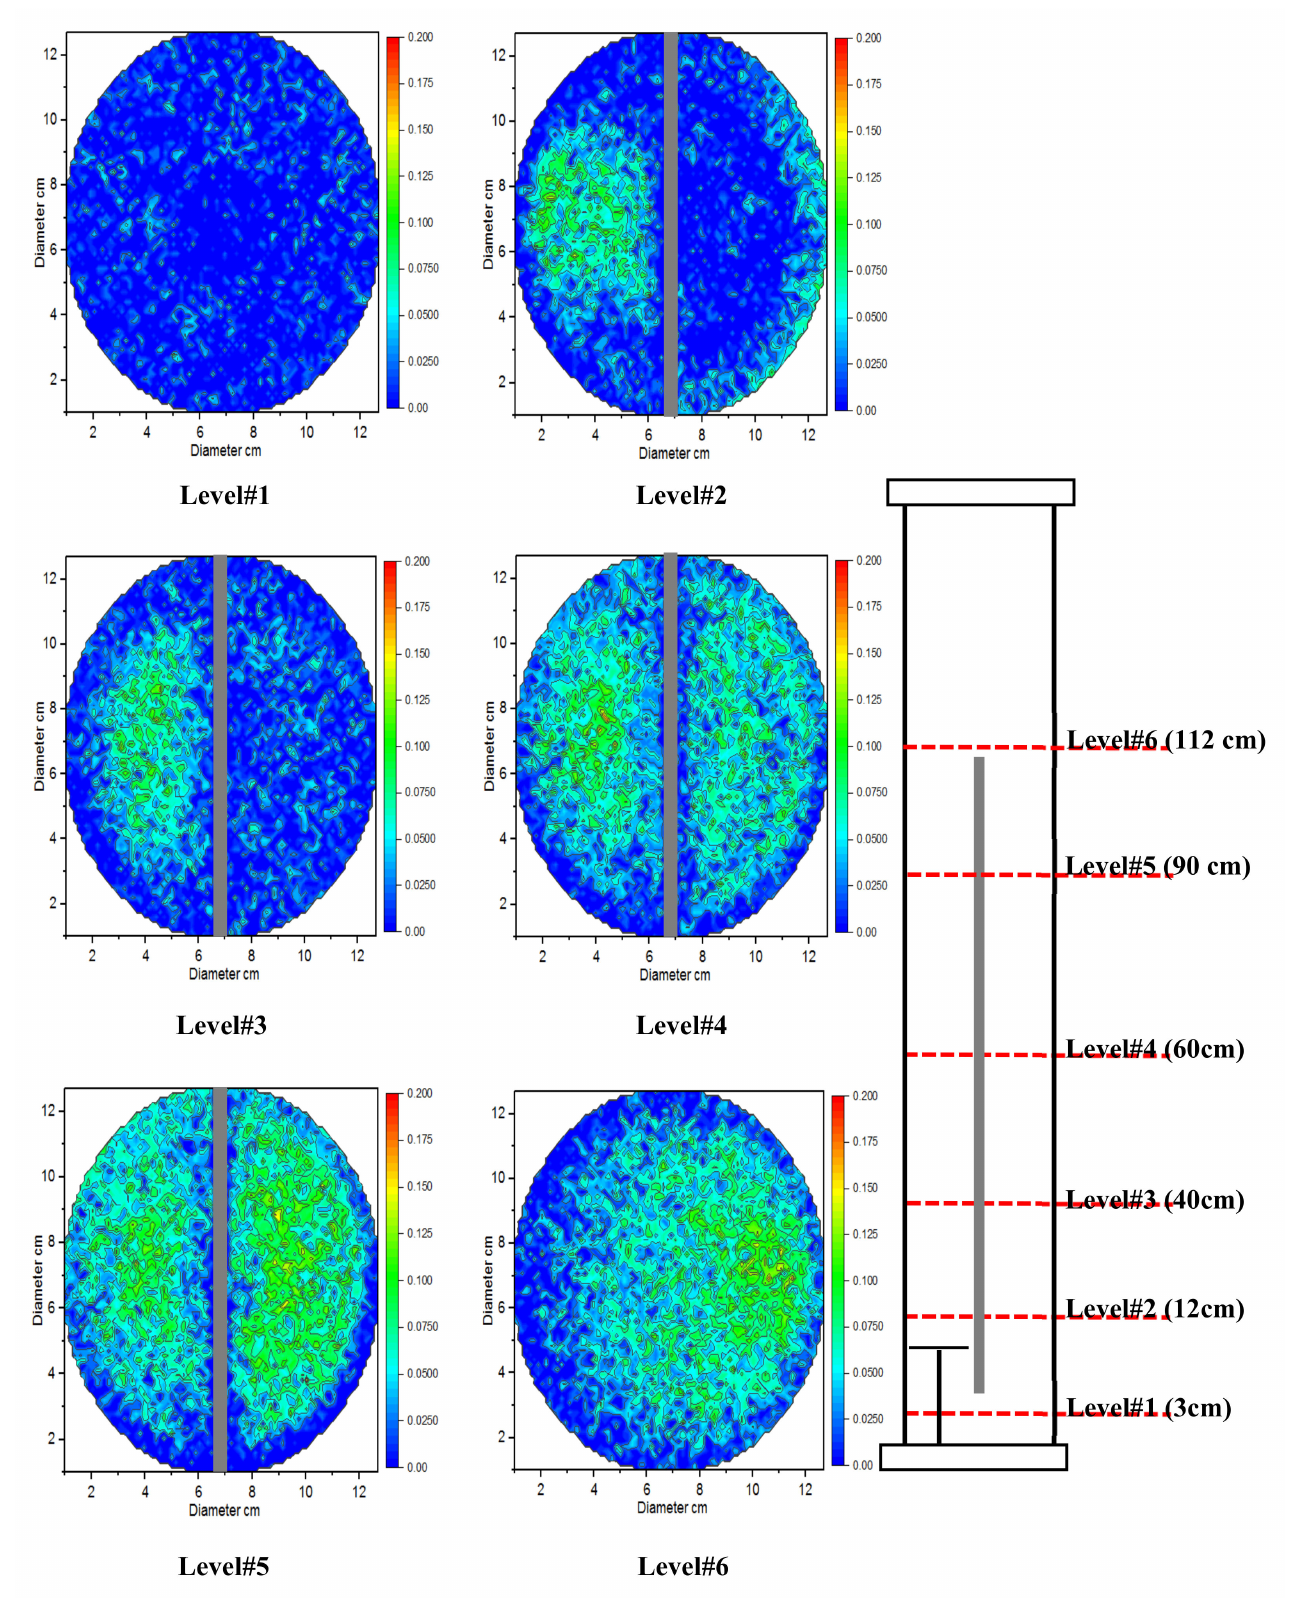
Figure 9. Cross-sectional distributions in gas holdup at different heights of split airlift reactor operated under gas velocity of 2